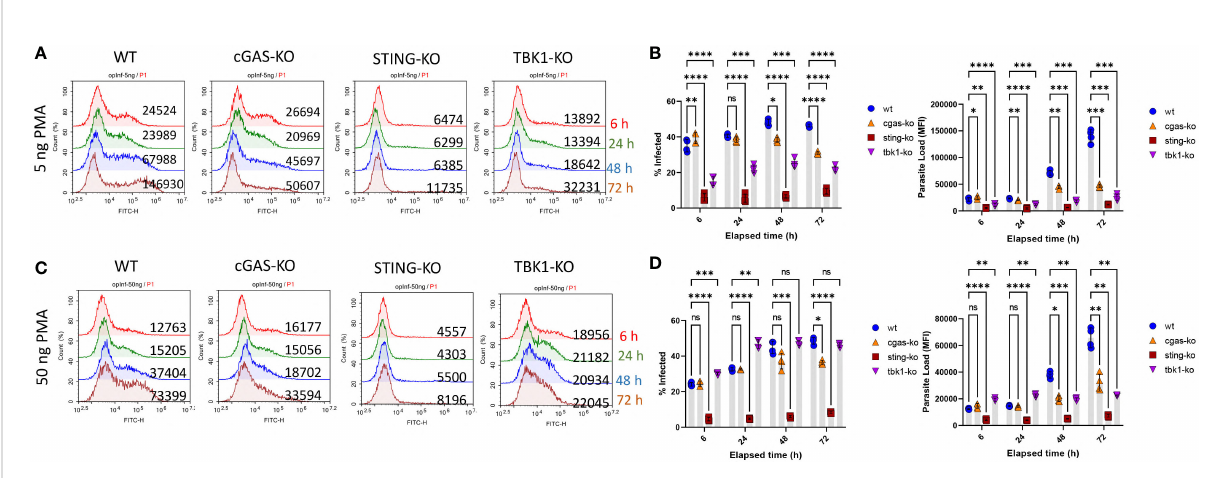
FIGURE 2 Kinetics of Leishmania infection in WT versus cGAS-, STING- or TBK1-knockout THP-1 cells. Low dose [ (A) and (B) or high dose (C) and (D) ] PMA differentiated THP-1 cells were infected with eGFP expressing L. major parasites at a MOI of 1:10 (macrophage:parasite). At indicated time points (6,24,48 and 72 h), infection percentages and parasite loads were quanti fi ed using a fl ow cytometer. Data presented in graphs represent the average of two independent experiments with technical replicates ± SD. Statistical comparisons to WT cells were based on two-way ANOVA followed by Tukey ’ s multiple comparison test. ns, not signi fi cant, *p ≤ 0.05, **p ≤ 0.01, ***p ≤ 0.001, ****p ≤